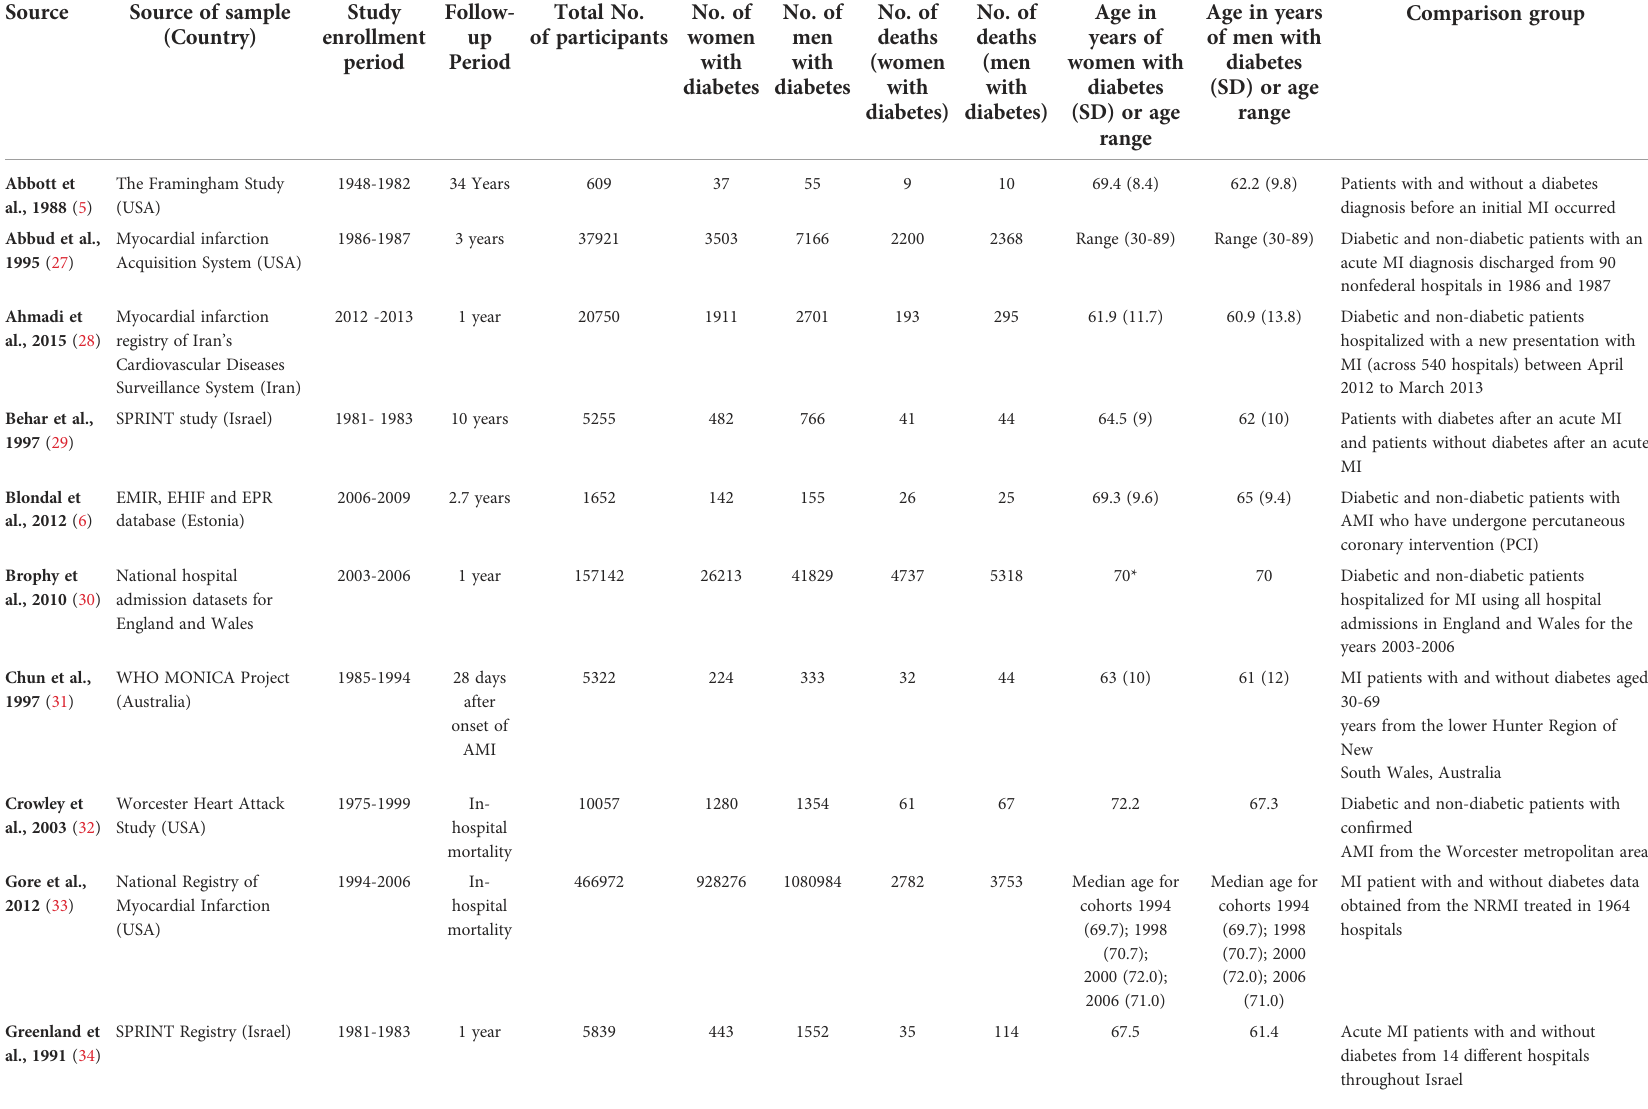
TABLE 1 Basic characteristics of included